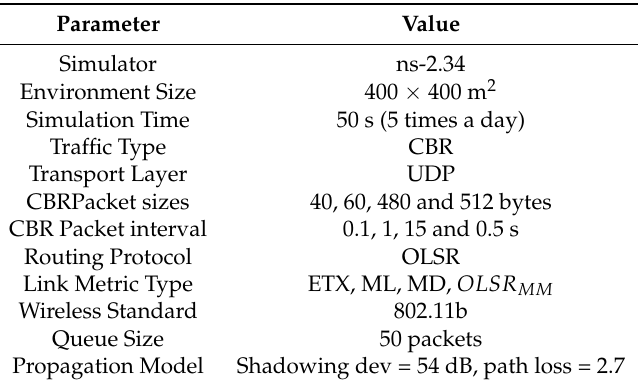
Table 3. Network simulation parameters.